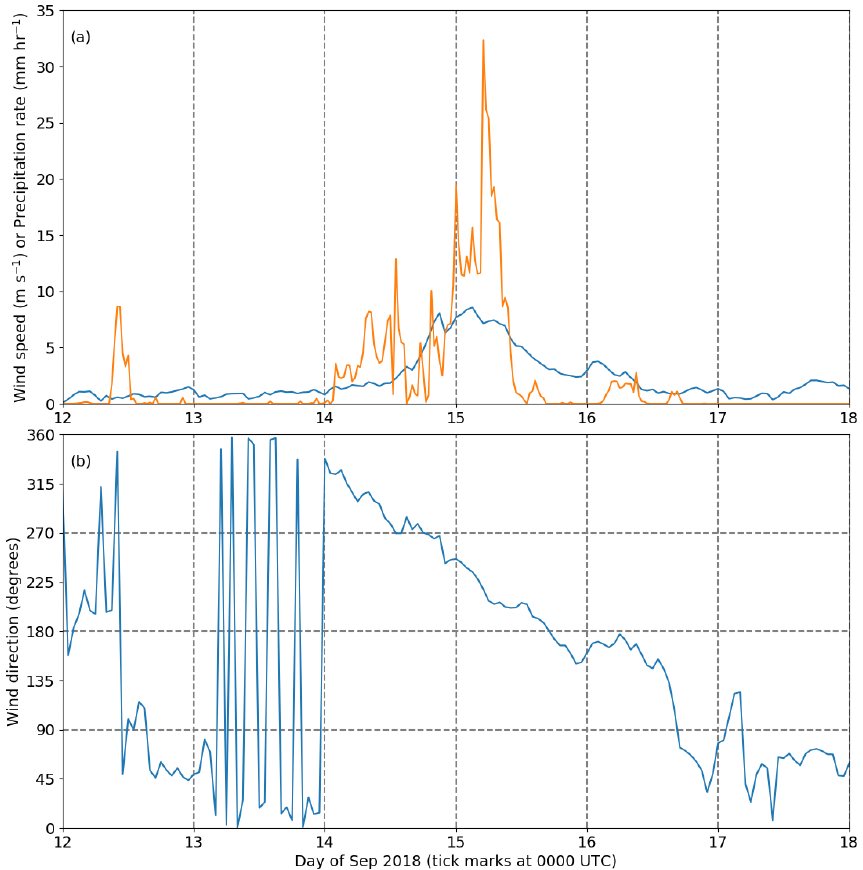
Figure 10. Time series of (a) wind speed (blue line) and precipitation rate (orange line) and (b) wind direction, from 12–18 September 2018, at the GPM IMERG grid point near Barangay Ucab. Note that wind directions indicate where winds “come from” (e.g. direction 270 indicates a wind coming from the